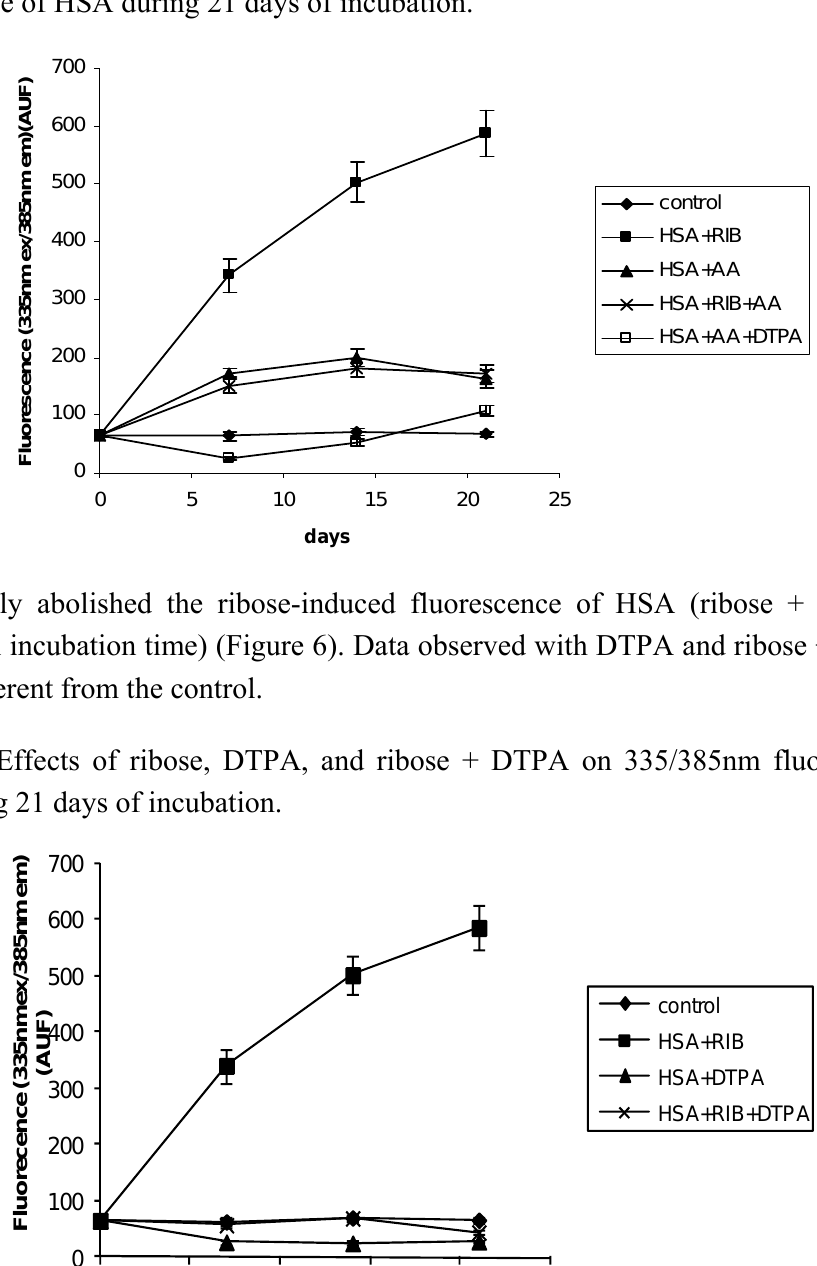
Figure 5. Effects of ribose, AA, ribose + AA, and AA + DTPA on 335/385 nm fluorescence of HSA during 21 days of incubation.